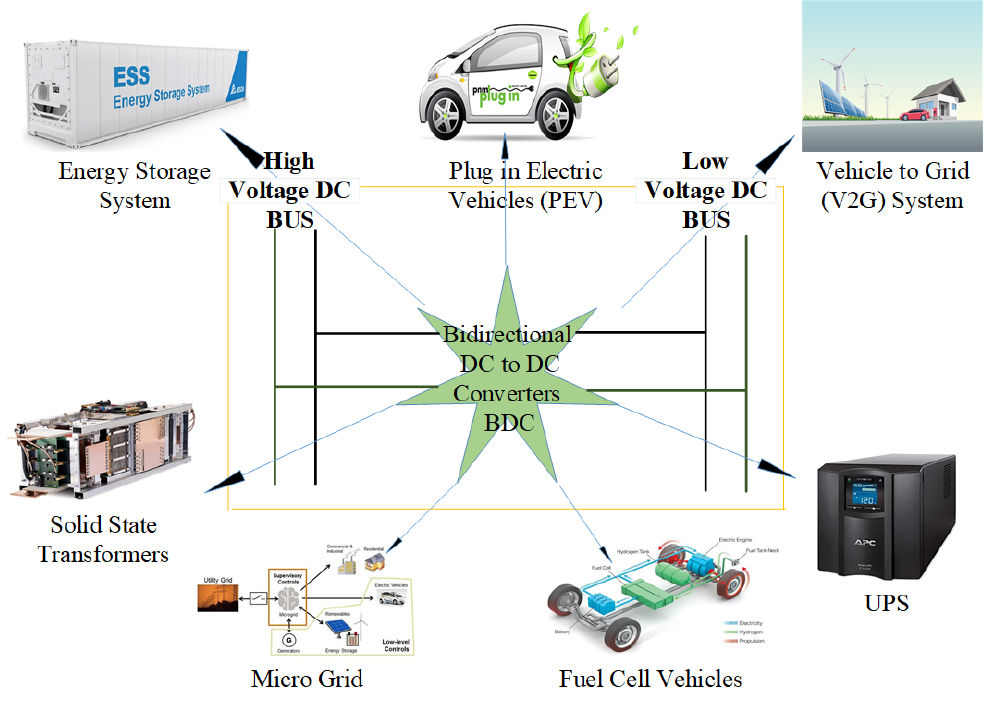
Figure 1. Applications of BDCs in various